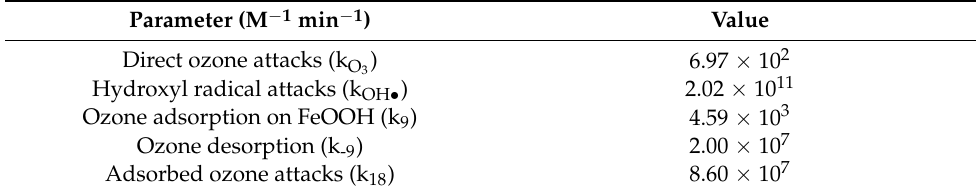
Table 4. Reaction rate constants for the SSA kinetic